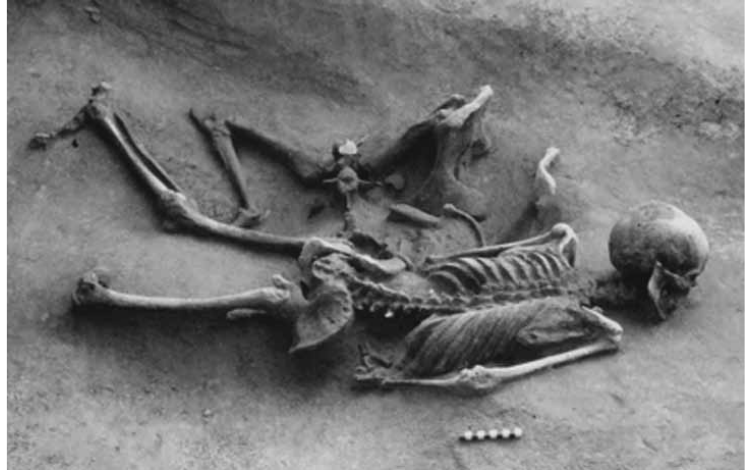
Figure 2. Colombara tomb 61 from Gazzo Veronese. Young woman buried face-down with a horse leg and a few animal bones (Salzani